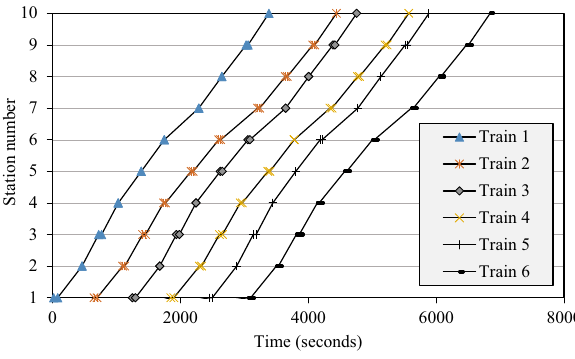
Fig. 5 The time-station graph of the train movement